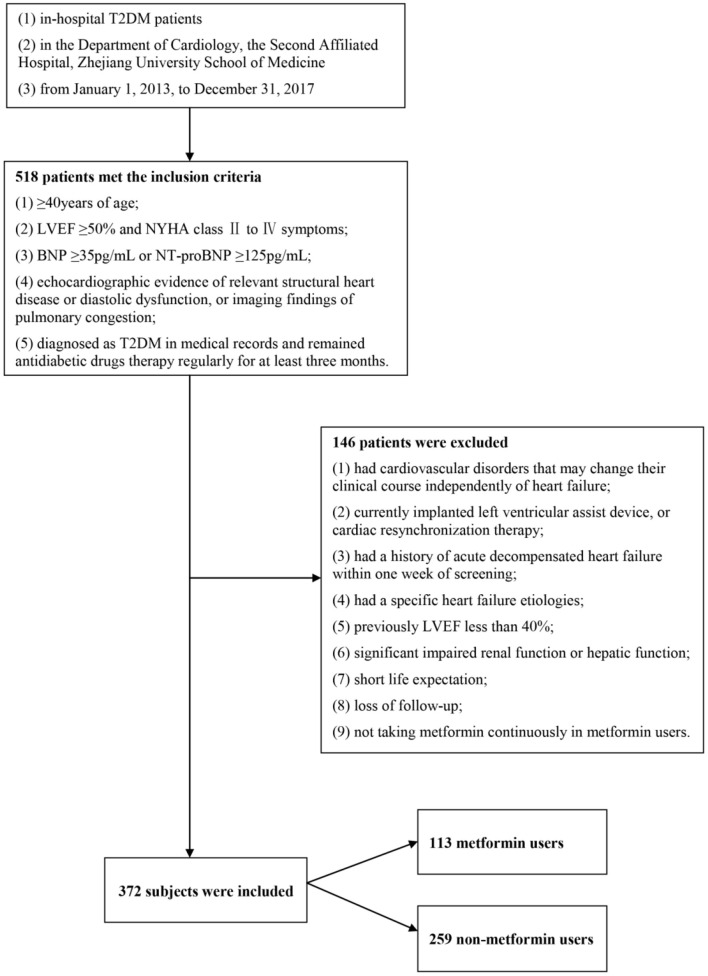
Study population. Among the 518 subjects, we excluded 146 subjects who did not meet our inclusion criteria. The remaining 372 subjects were divided into the metformin group (n = 113) and the non-metformin group (n = 259).